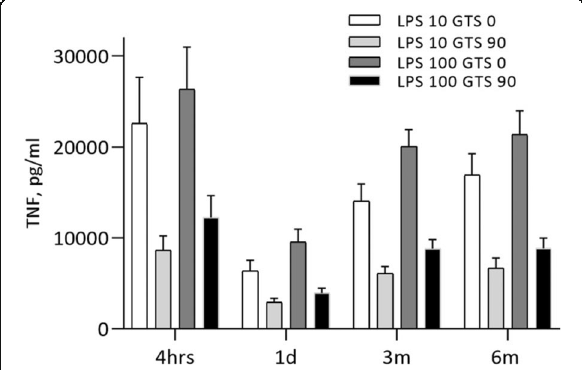
Fig. 4 RDN: TNF-levels in whole blood model with GTS 21. Whole blood stimulated with LPS-concentration 10 and 100 ng/mL compared with addition of GTS 21 90 μ mol/L. P-TNF (after 4 hours incubation in 37C ˚ ) before RDN at 1 day after RDN and at 3 and 6 months follow up. p < 0.001 at all time points. Data presented as median and (10-90) percentiles